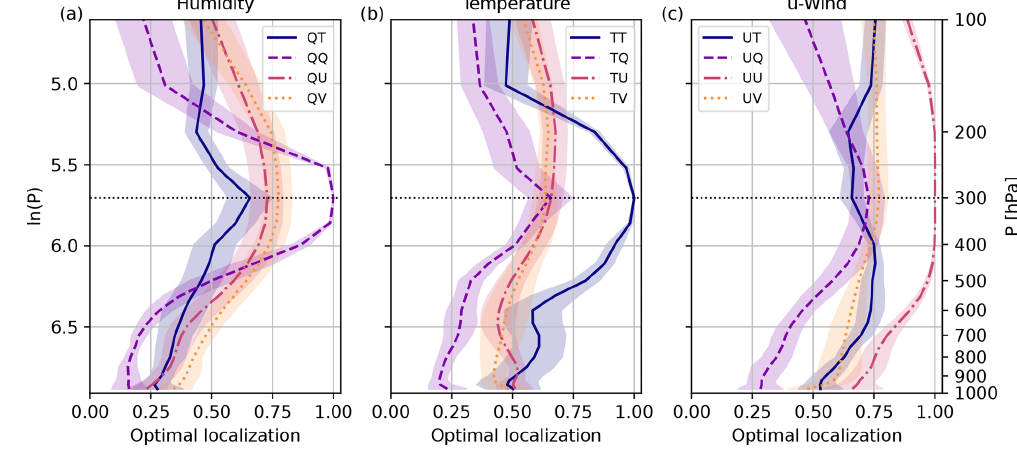
Figure 4. Same as Fig. 3 but for reference level 300hPa.